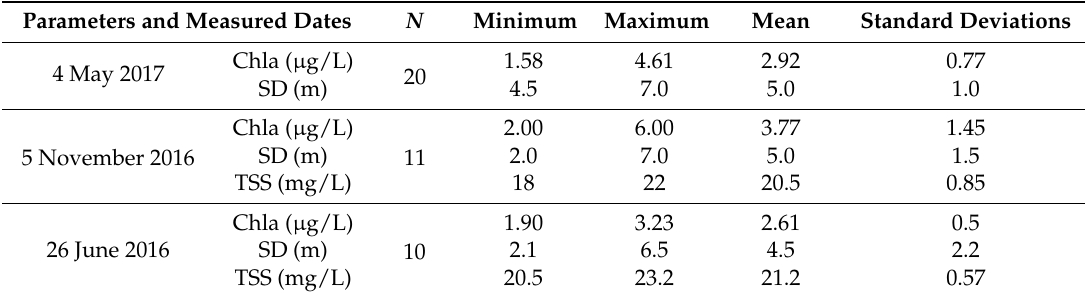
Table 1. Descriptive statistics of water parameters obtained in three surveys. Parameters and Measured Dates